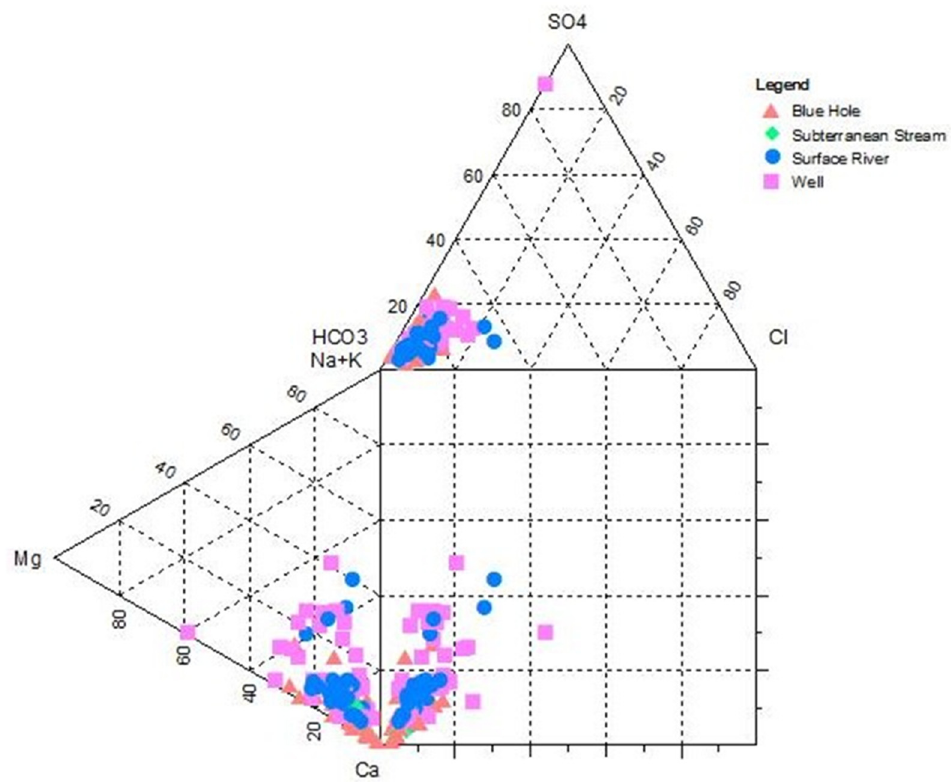
Figure 2. Piper diagram of major ions in different water types of the Huixian karst